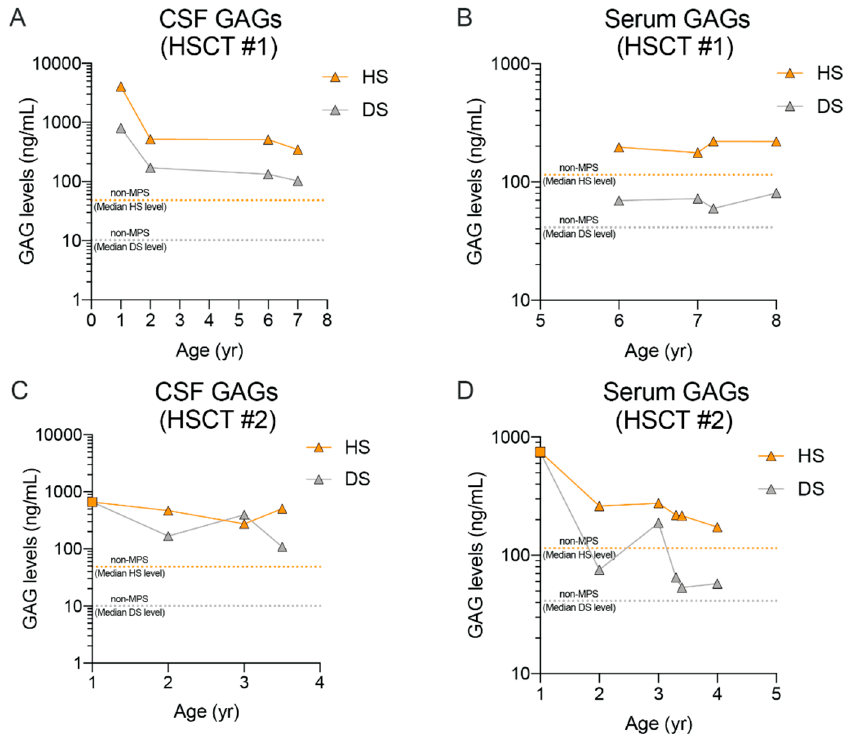
Figure 5. Longitudinal HS and DS levels in CSF and serum of nMPS II patients with HSCT. CSF and serum HS and DS measured by LC-MS/MS and quantified against calibration curves generated using pure reference standards for D0A0, D0S0, and D0a4. HS (orange; sum of D0A0 and D0S0) and DS (gray; D0a4) are plotted again age to show time-dependent changes in GAGs post HSCT. For HSCT patient #1 ( A , B ), only post-transplant samples were available, with the earliest collection at age 1. For HSCT patient # 2 ( C , D ), the sample collected at age 1 is a pre-HSCT sample (closed squares). Median HS and DS values for the non-MPS control group are shown for reference. Refer to Figure 4 for individual data points for control groups.